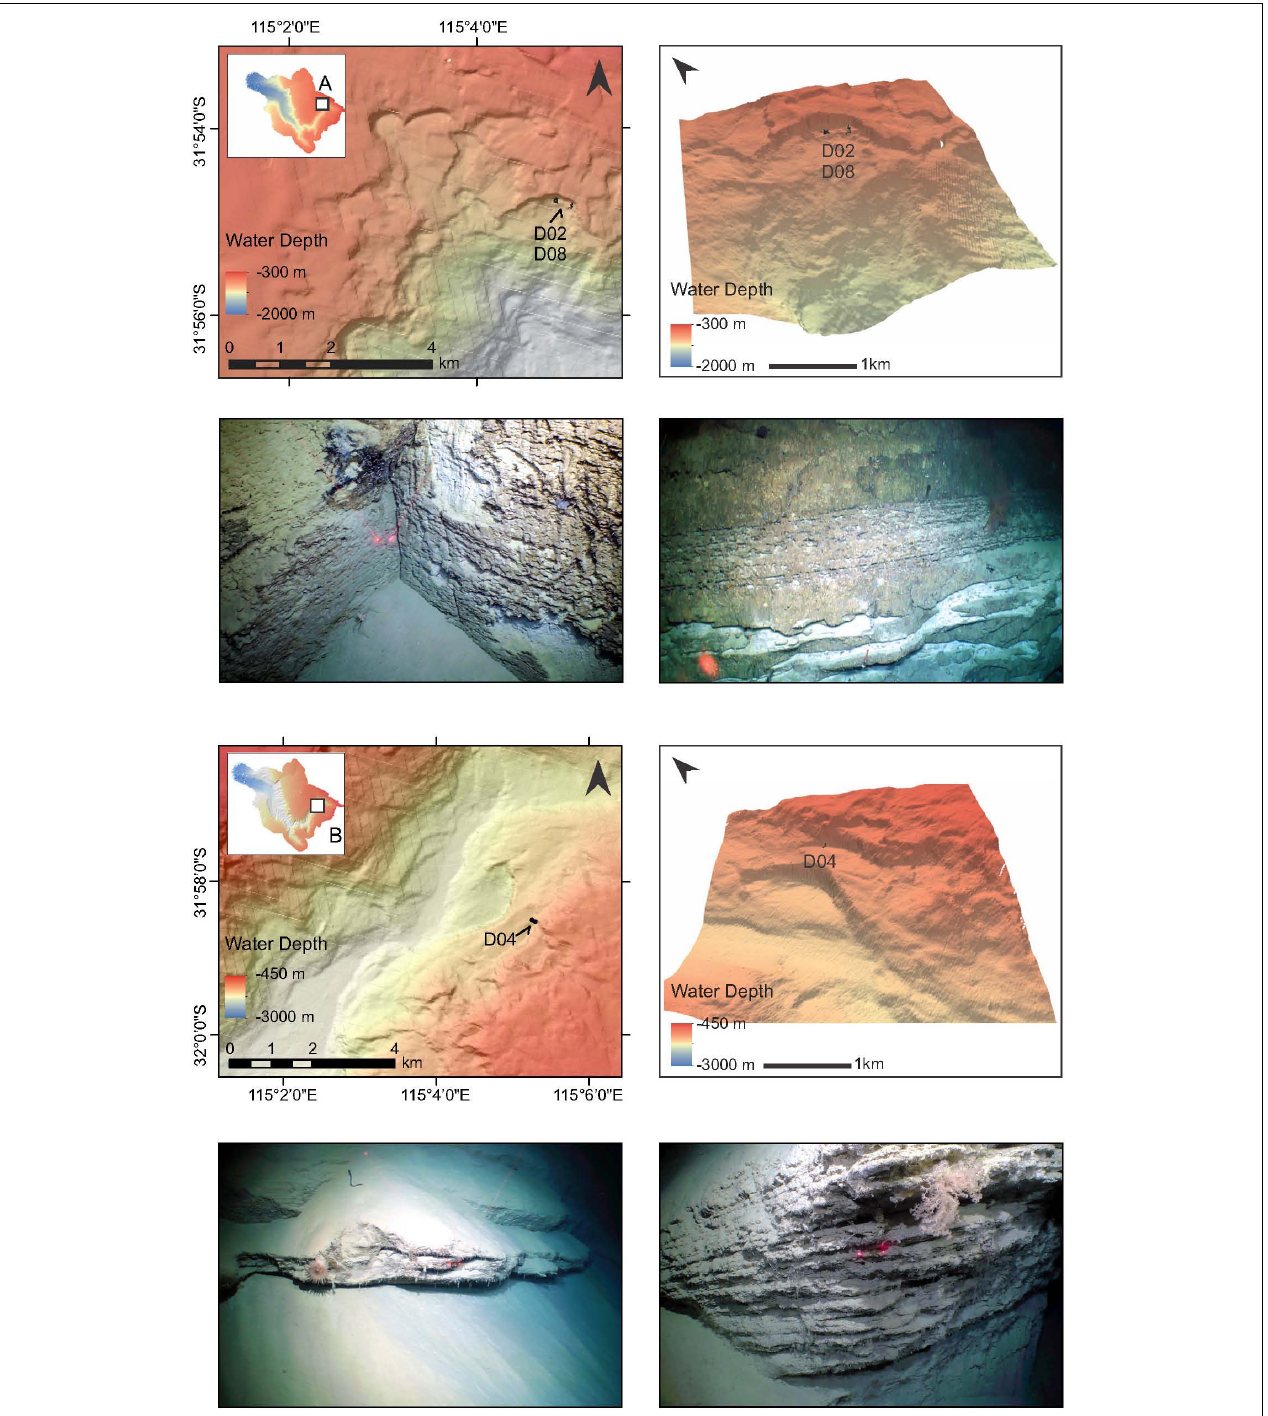
FIGURE 2 | High-resolution bathymetry maps and photos of lithologies of the canyon walls and substrates at ROV dive Sites A and B (note insets), located in the northeast region of the canyon system. Black lines on the bathymetry maps depict ROV tracks, with each dive number indicated.